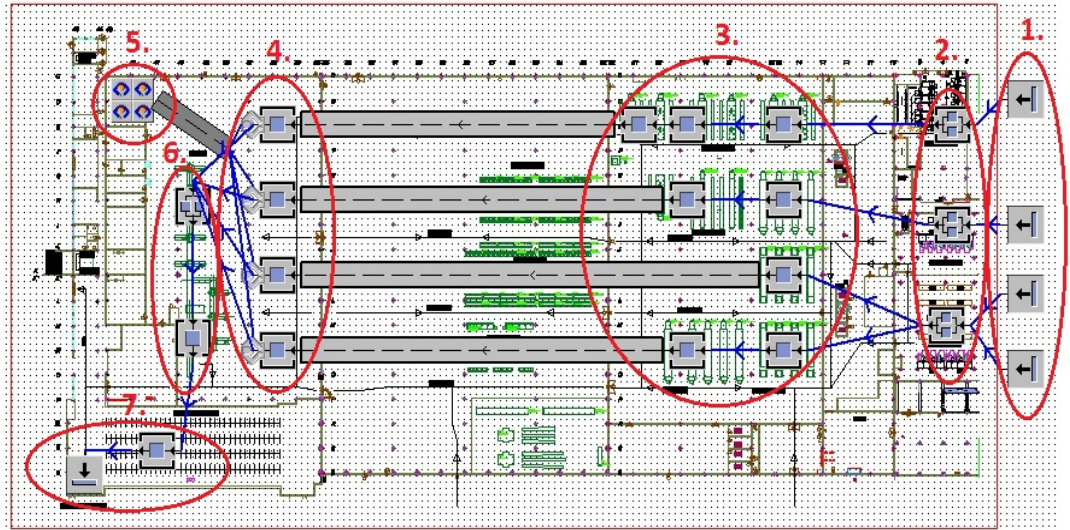
Figure 4. Model of the production process.